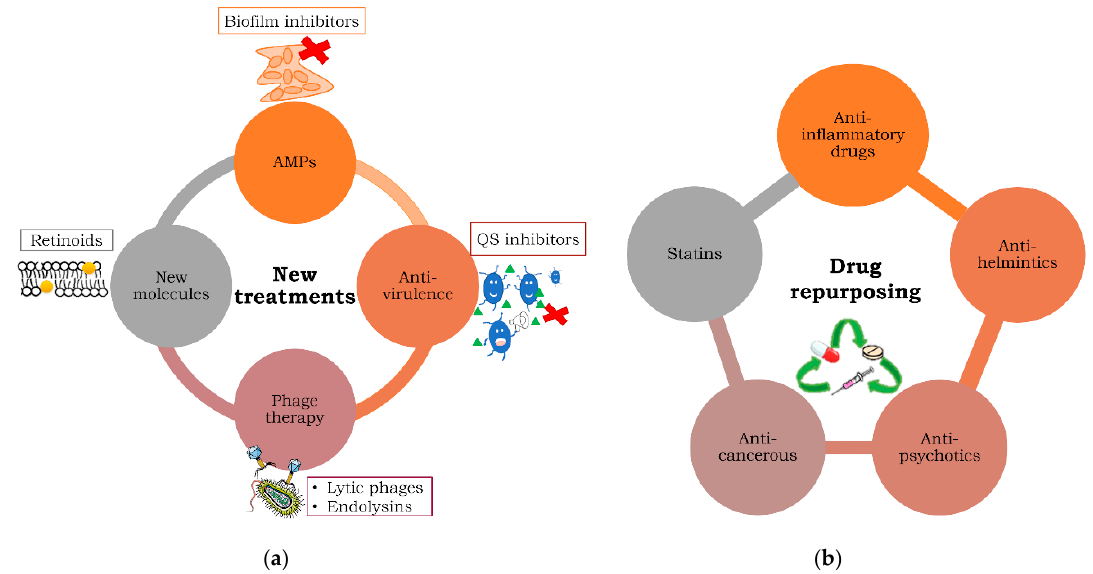
Figure 1. Anti-infectious strategies investigated with the aim of combating resistant and persistent bacteria. ( a ) Clockwise from the top: AMPs: antimicrobial peptides, including biofilm inhibitors; QS: quorum sensing. The green triangles illustrate the acyl-homoserin lactones that bacteria secrete as QS modulators. Phage therapy includes all the clinical trials in which a combination of lytic phages or parts of these (endolysins) are used against bacterial infections with therapeutic aims. Finally, new molecules encompass all synthetic compounds displaying antibacterial activity, such as retinoids (indicated by yellow circles inserted in the membrane). ( b ) Repurposing encompasses all the FDA (Food and Drug Administration)-approved drugs with potentially antibacterial effects.